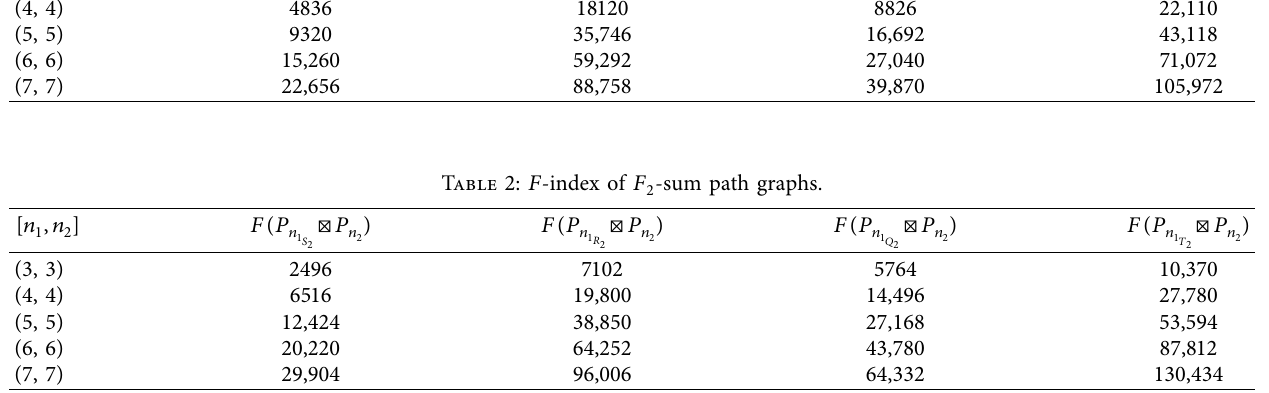
Table 1: F -index of F